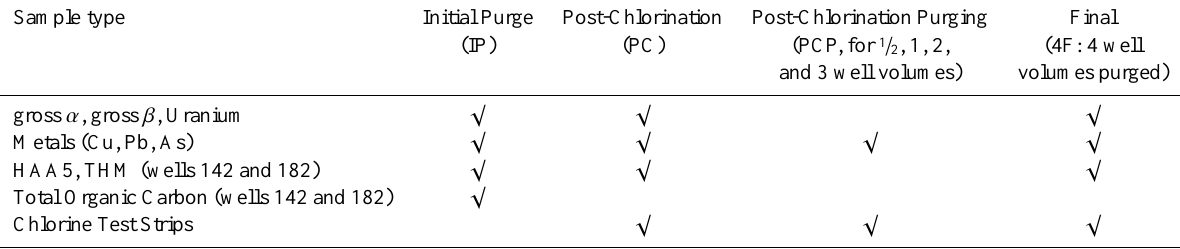
Table 2. Sampling intervals used, with associated chemical constituents measured.